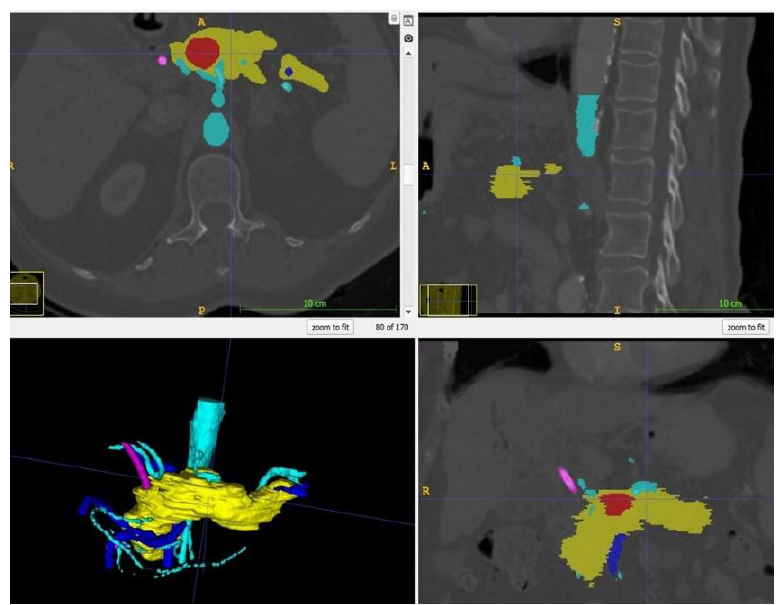
Figure 2. Screenshot of ITK Snap with the tumor in red, the pancreas in yellow, the arteries in light blue, the veins in dark blue and the splint in pink.